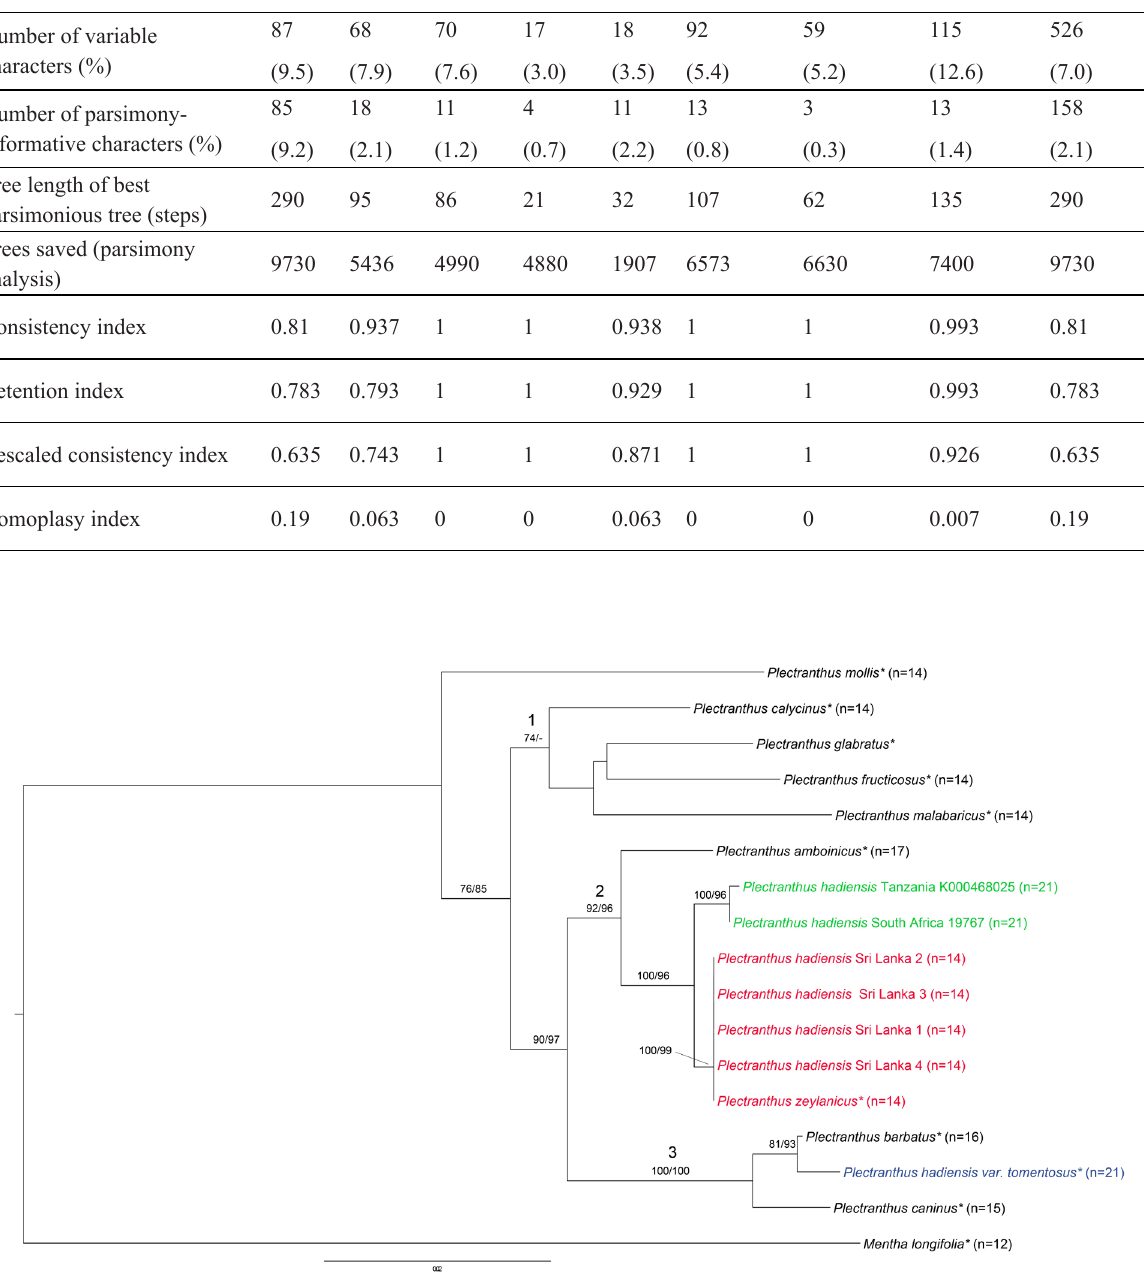
Figure 2: Maximum likelihood tree showing three clades (1-3) for Plectranthus taxa included in the study. Bootstrap percentages (≥ 70%) from maximum likelihood and maximum parsimony analyses are shown for each node. A hyphen indicates bootstrap support < 70%. The mean haploid chromosome count (n) is given for each species. The chromosome count for P. zeylanicus was obtained from Thoppil (1993). All other chromosome counts are from the Chromosome Counts Database (CCDB, version 1.46, Rice et al ., 2015). As the Sri Lankan morph of P. hadiensis was formerly known as P. zeylanicus , we have assumed that the chromosome count for the Sri Lankan specimens of P. hadiensis is the same as that for P. zeylanicus . Sequences obtained from GenBank are indicated with an